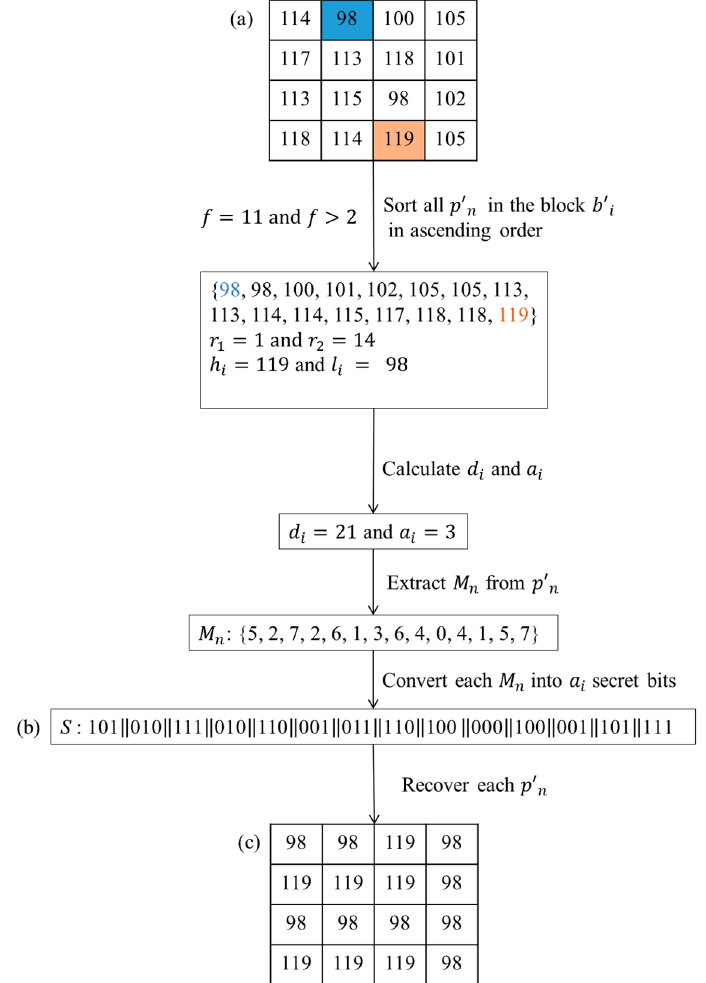
Figure 7. ( a ) The modified block 𝑏′ (cid:3036) sized 4 × 4 , ( b ) Secret data S and ( c ) block 𝑏 (cid:3036) sized 4 × 4 .